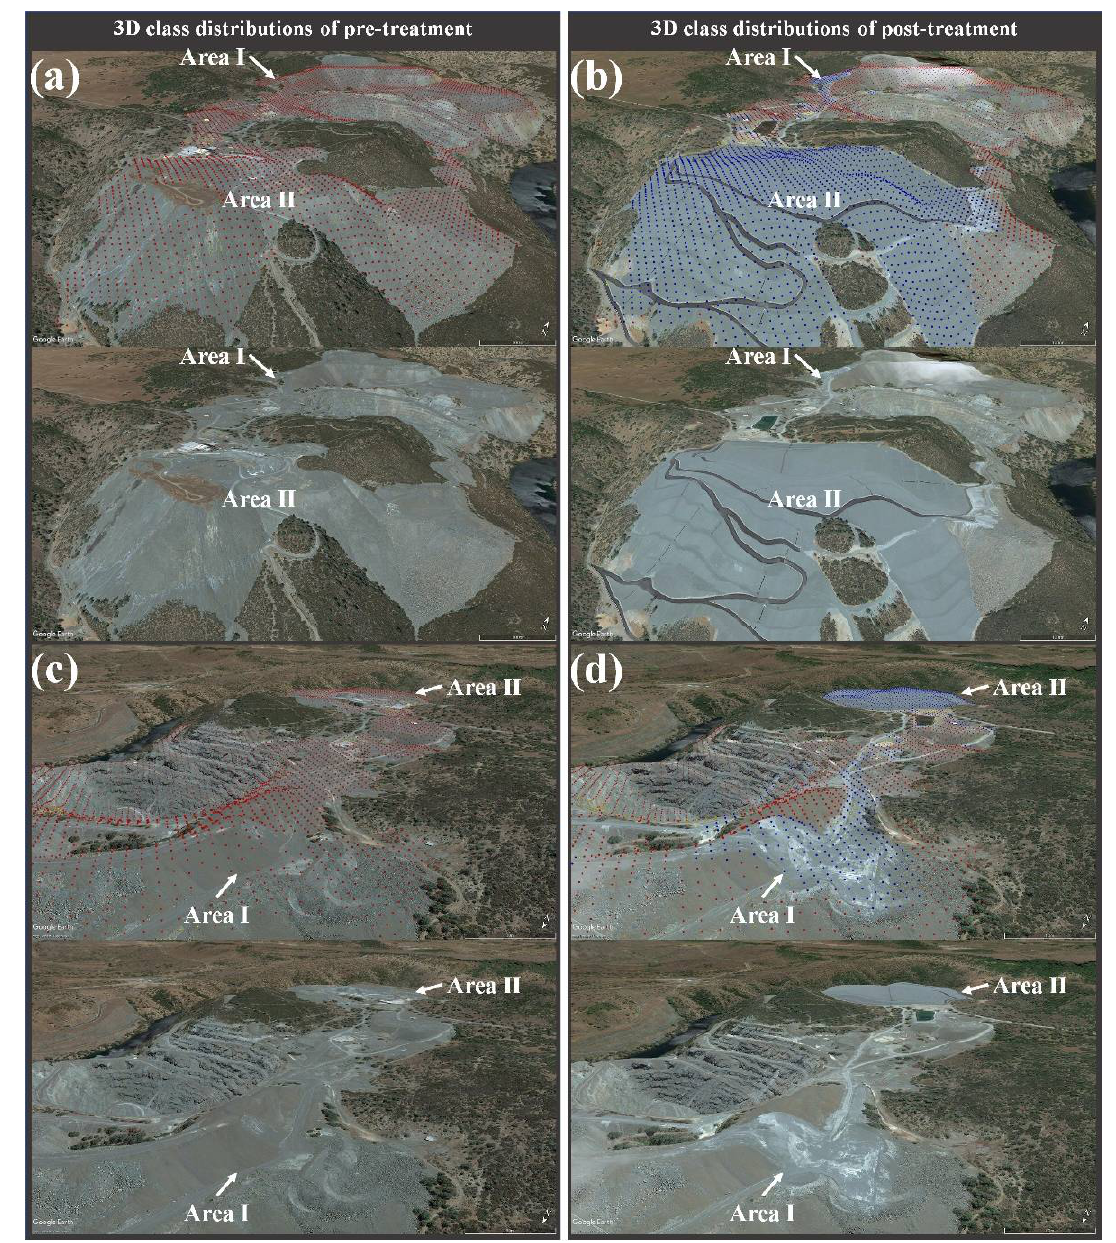
Figure 9. Showing 3D high-resolution satellite image-based (Google Earth) views for the same locations of pre- ( a , c ) and post-treatments ( c , d ). Red, blue, and yellow color classes are the output of classifications from NOAI, CAP, and HRI BLR models, respectively. The background satellite images in ( a , c ) and ( b , d ) represent June 2013 and May 2018. The remediated areas are marked as Areas I and II with an arrow and text.